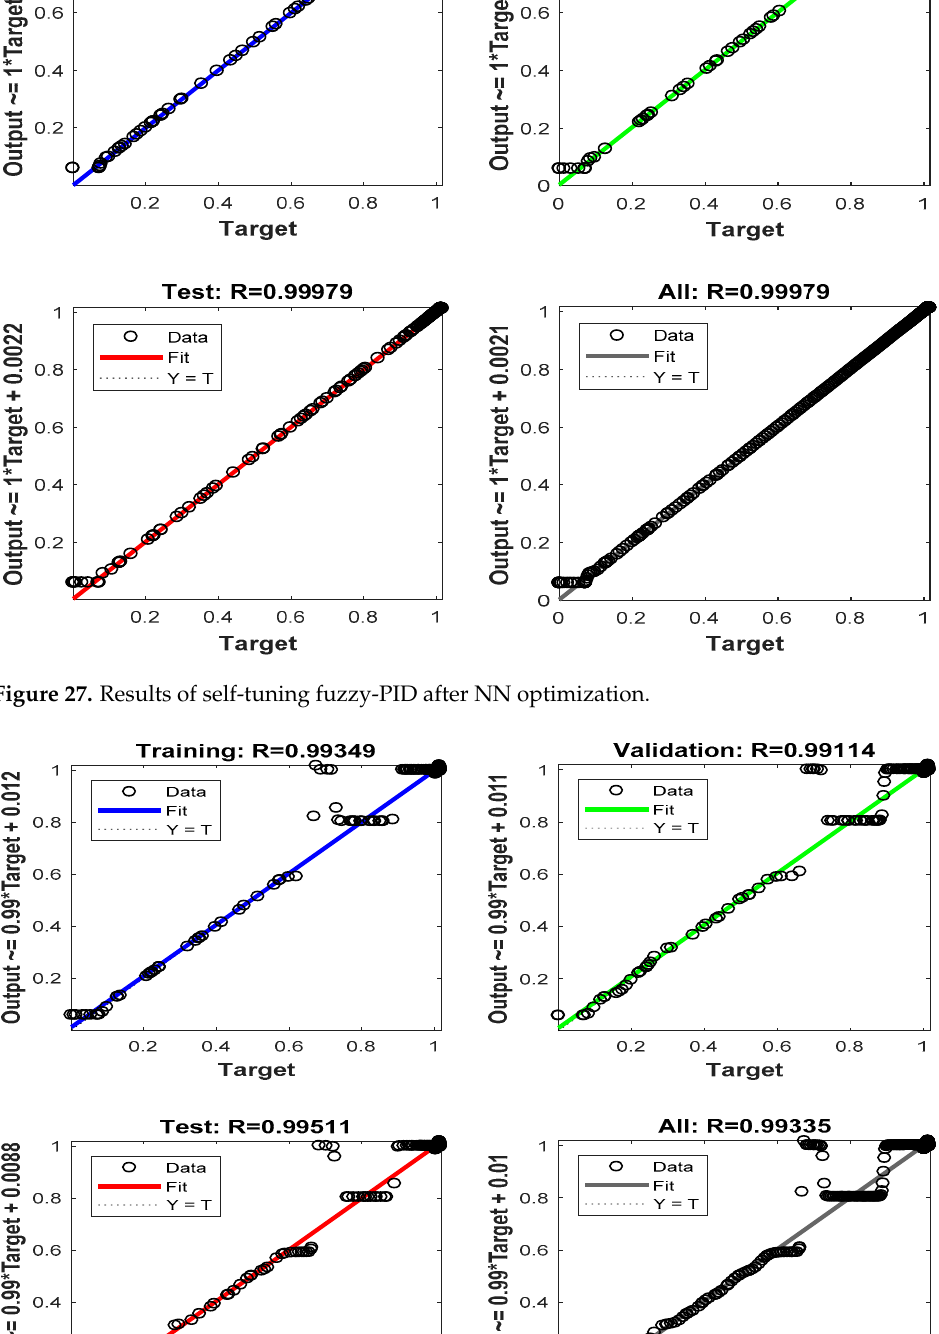
Figure 28. Results of PID after NN optimization.